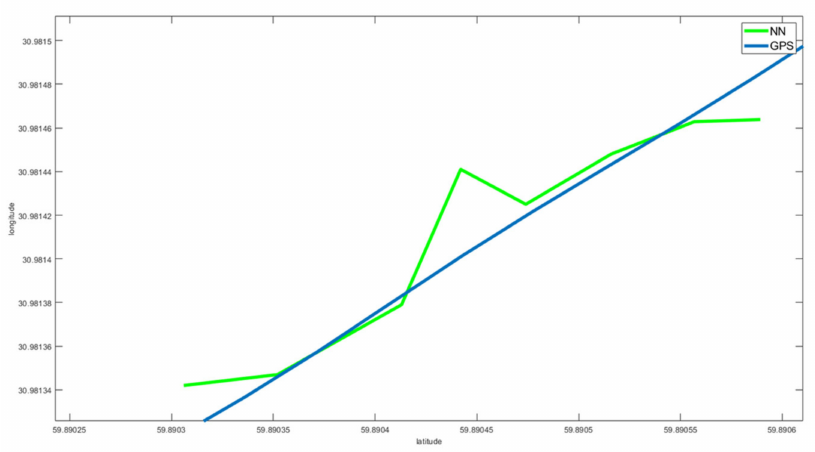
Figure 8. Comparison of the trajectory predicted by the neural network with the reference trajectory on the straight section of the path.